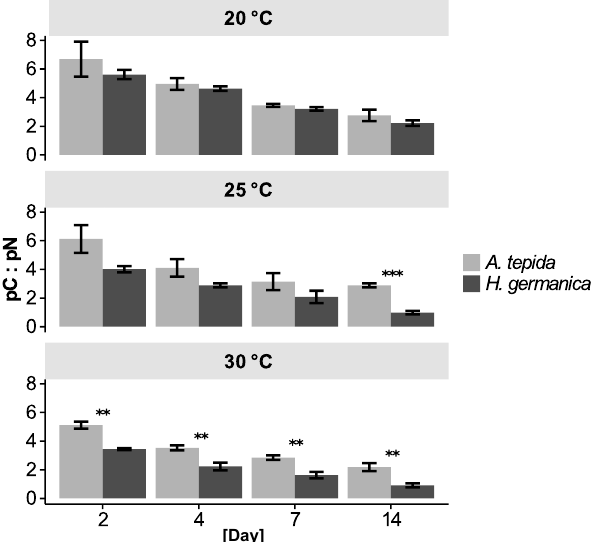
Figure 6. Ratios of cytoplasmic pC:pN ratios. Biomass normalised pC:pN within foraminiferal cytoplasm. Error bars denote stan- dard deviation, stars indicate significant differences of pC:pN ra- tios between the two species on the respective days (Welch’s t test; * p < 0.050, ** p < 0.010; *** p < 0.001).